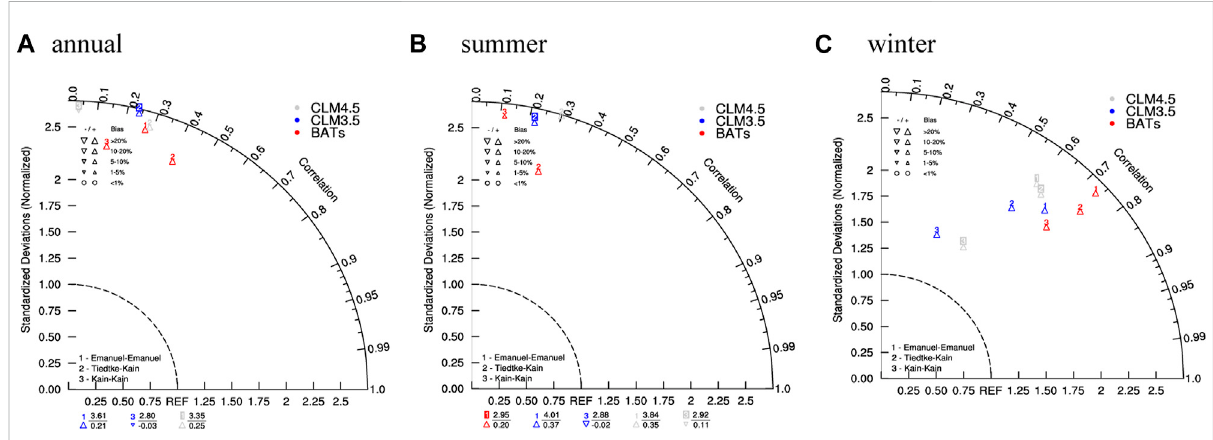
FIGURE 3 Taylordiagramsofannual,summerand winterprecipitationintheUYRB.(Valuesatthebottomarestatisticsthatexceed thethresholdofTaylor